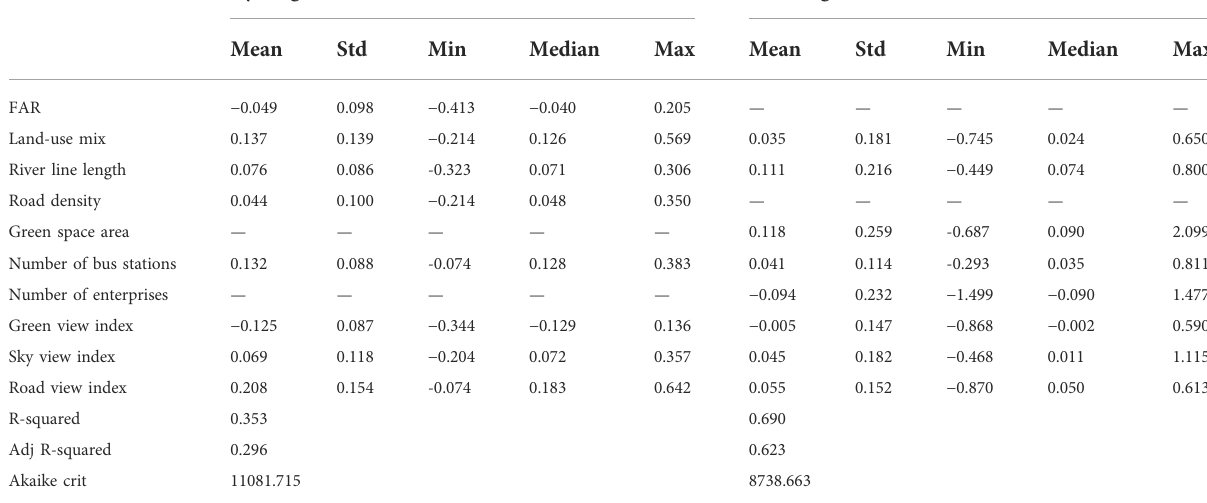
TABLE 4 GWR modeling